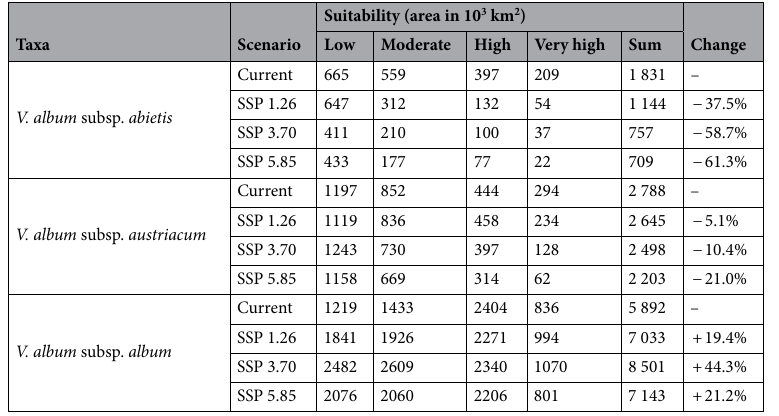
Table 2. Suitable geographical area of V. album in the tested climate models, divided into four classes according to suitability: low (0.1–0.24), moderate (0.25–0.49), high (0.50–0.74) and very high (≥ 0.75). Significant values are in [bold].